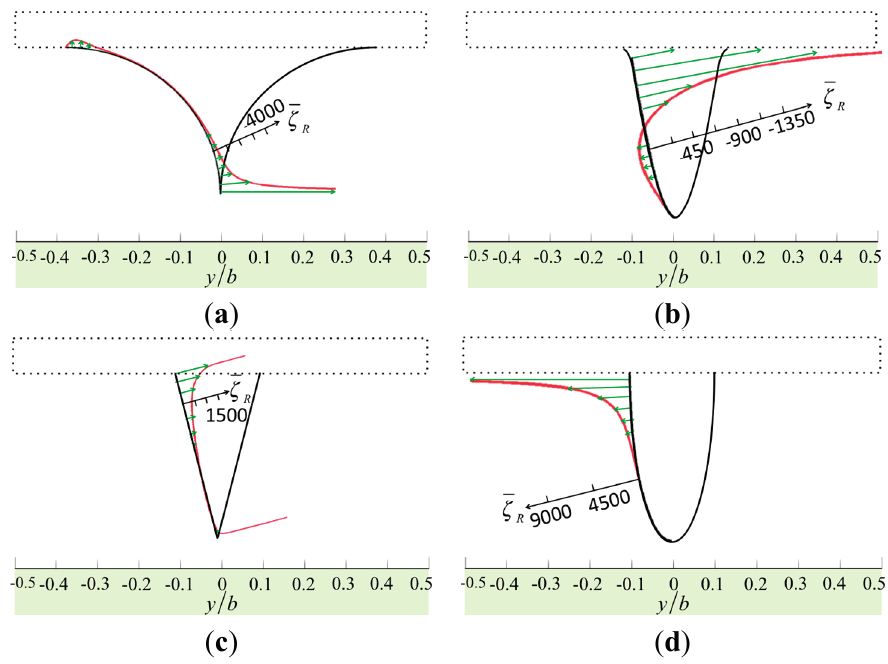
Figure 3. The normalized vorticity in real part over the surfaces of the tips: ( a ) the sharp model; ( b ) the sine-shaped model; ( c ) the cone-shaped model; and ( d ) the bell-shaped